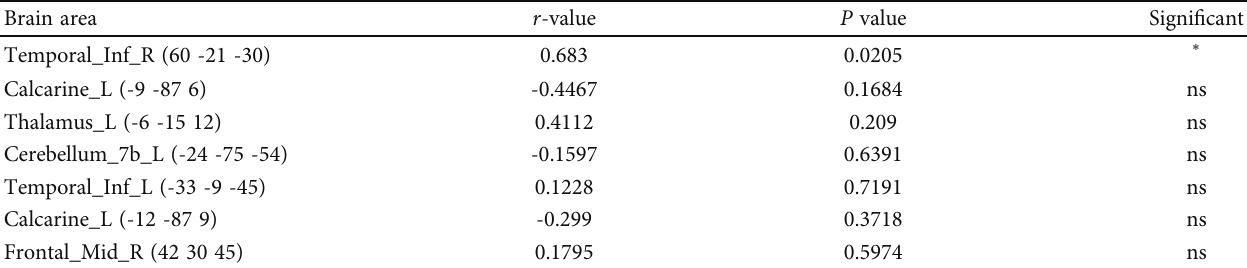
Figure 5: The di ff erence of mfALFF in slow-5 band between patients before and after treatment and HCs (pos: stroke patients after treatment; pre: stroke patients before treatment; con: healthy controls; ∗ indicated P < 0 : 05 ; ∗∗ indicated P < 0 : 01 ; ∗∗∗∗ indicated P < 0 : 0001 ). Table 6: The correlation between the change rate of regional brain index (mfALFF) and swallowing function score in stroke patients before and after